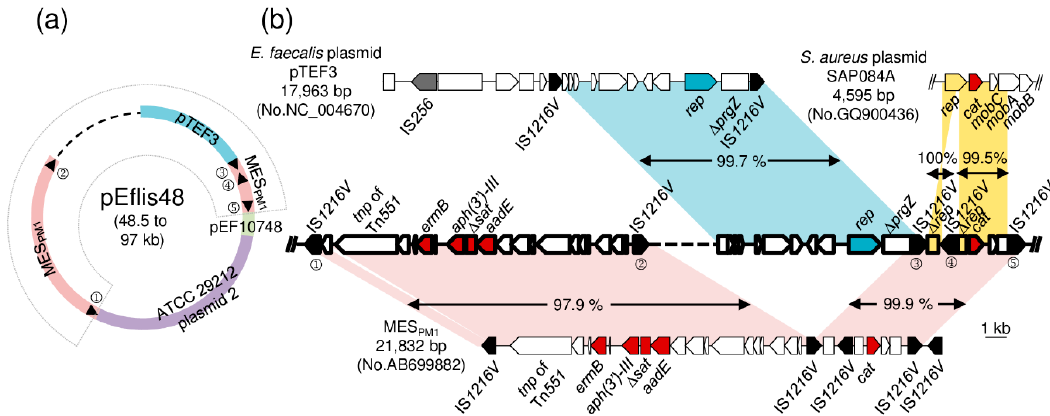
Figure 3. Structure of pEflis48 in E. faecalis N48. ( a ) Schematic map of pEflis48 is shown. Blue, pink, green, and purple colors in the circle indicate homologous regions to E. faecalis plasmid pTEF3 (GenBank accession number NC_004670), ST59 MRSA MES PM1 (GenBank accession number AB699882), E. faecalis plasmid pEF10748 (GenBank accession number MK993385), and E. faecalis ATCC 29,212 plasmid 2 (GenBank accession number CP008814). The black triangle indicates the position of IS 1216V . The dashed line in the circle indicates an unresolved sequence. ( b ) Genetic organization of the fan-shaped region indicated in ( a ) is shown. The arrow indicates an open reading frame. The rectangle indicates a truncated gene. Black, grey, red, and blue arrows indicate tnp (transposase) of IS 1216V , tnp of IS 256 , resistance determinates, and rep (replication initiator) gene, respectively. Homologous regions to E. faecalis plasmid pTEF3, S. aureus plasmid SAP084A, and MES PM1 are shaded in blue, yellow, and red, respectively.